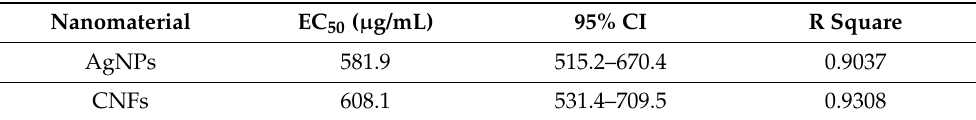
Table 2. Mean effective concentration (EC 50 ) of keratinocyte (HaCaT) cells after treatment with AgNPs and CNFs at an exposure of 24 h. Mean EC 50 in µg/mL, confidence limits 95% (CI) and goodness of fit (R square) are shown.